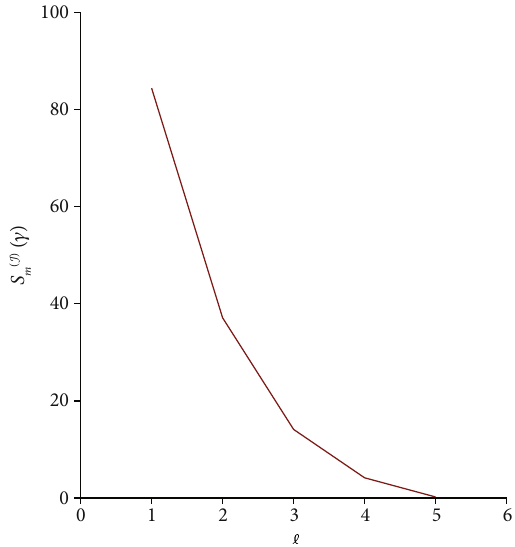
Figure 10: Variation of the Rényi entropy for the momentum space S ð R Þ m ð γ Þ with respect to the angular momentum quantum number ℓ with μ = c = ℏ = 1 , Η = 20 , T = 10 , ϱ = 0 : 1 , and σ = 0 : 01 for D = 3 :